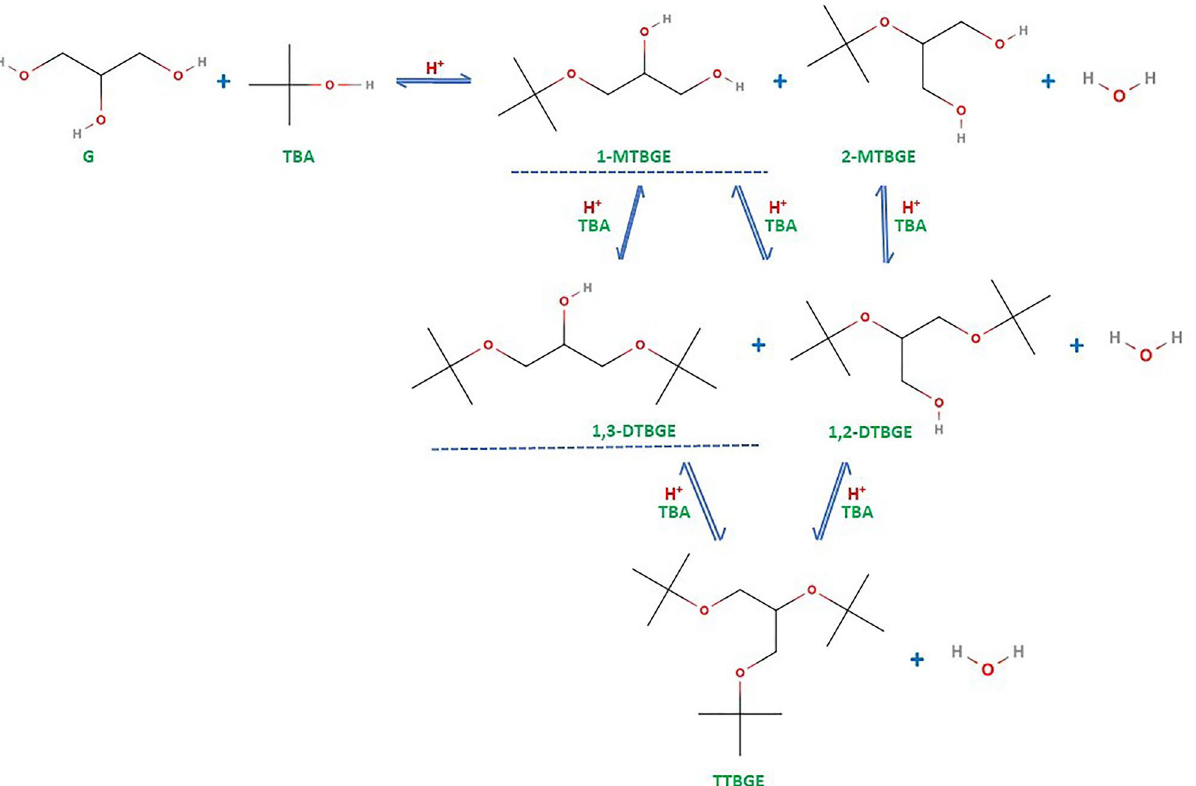
Figure 1. The scheme of reaction between glycerol and tert-butyl alcohol under acidic